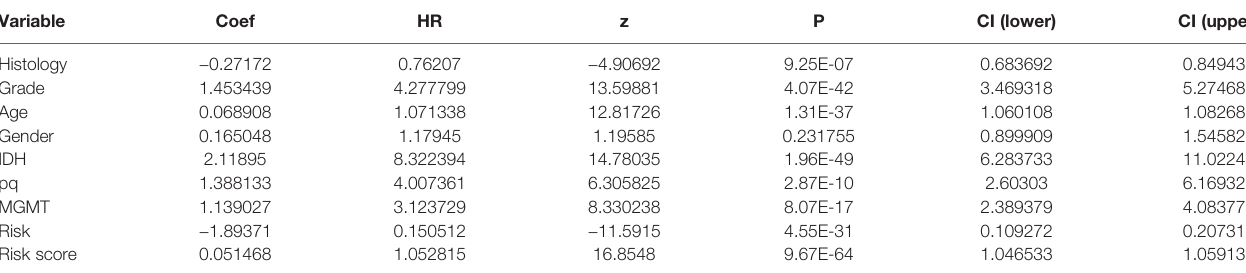
TABLE 3 | Univariate Cox regression of clinical